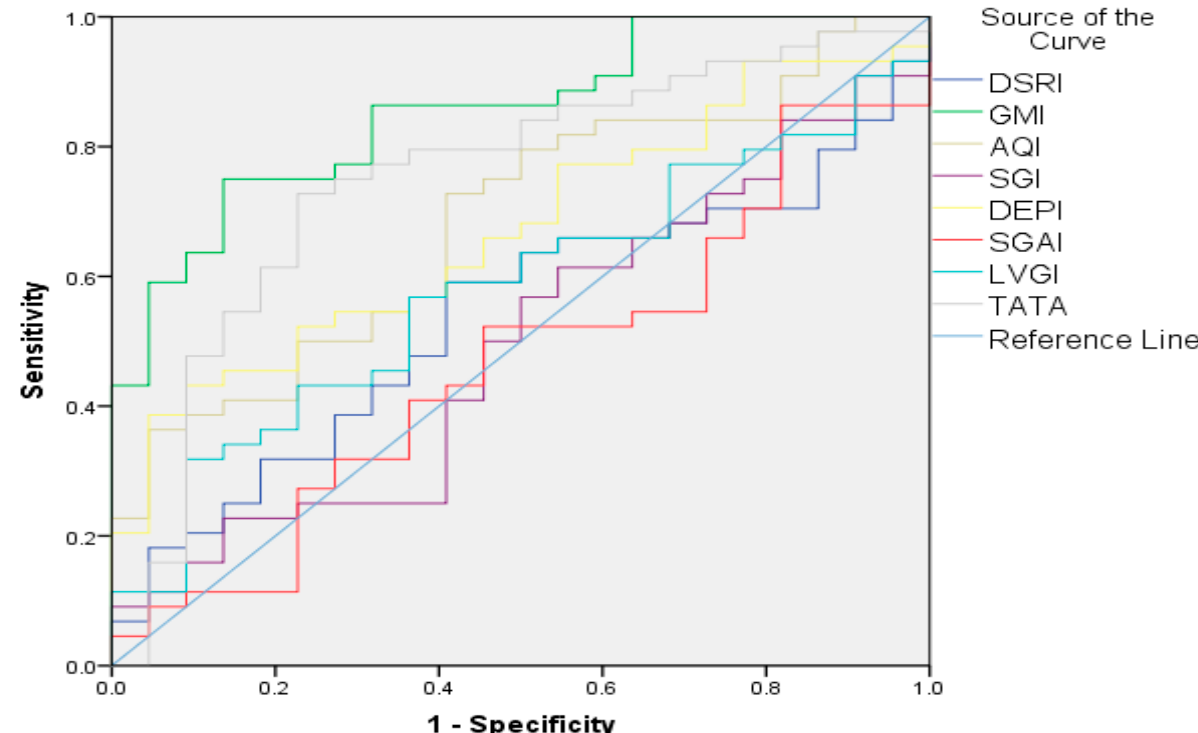
Figure 1. Roc curve analysis for the univariate situation. Source: authors’ construction in SPSS 24.